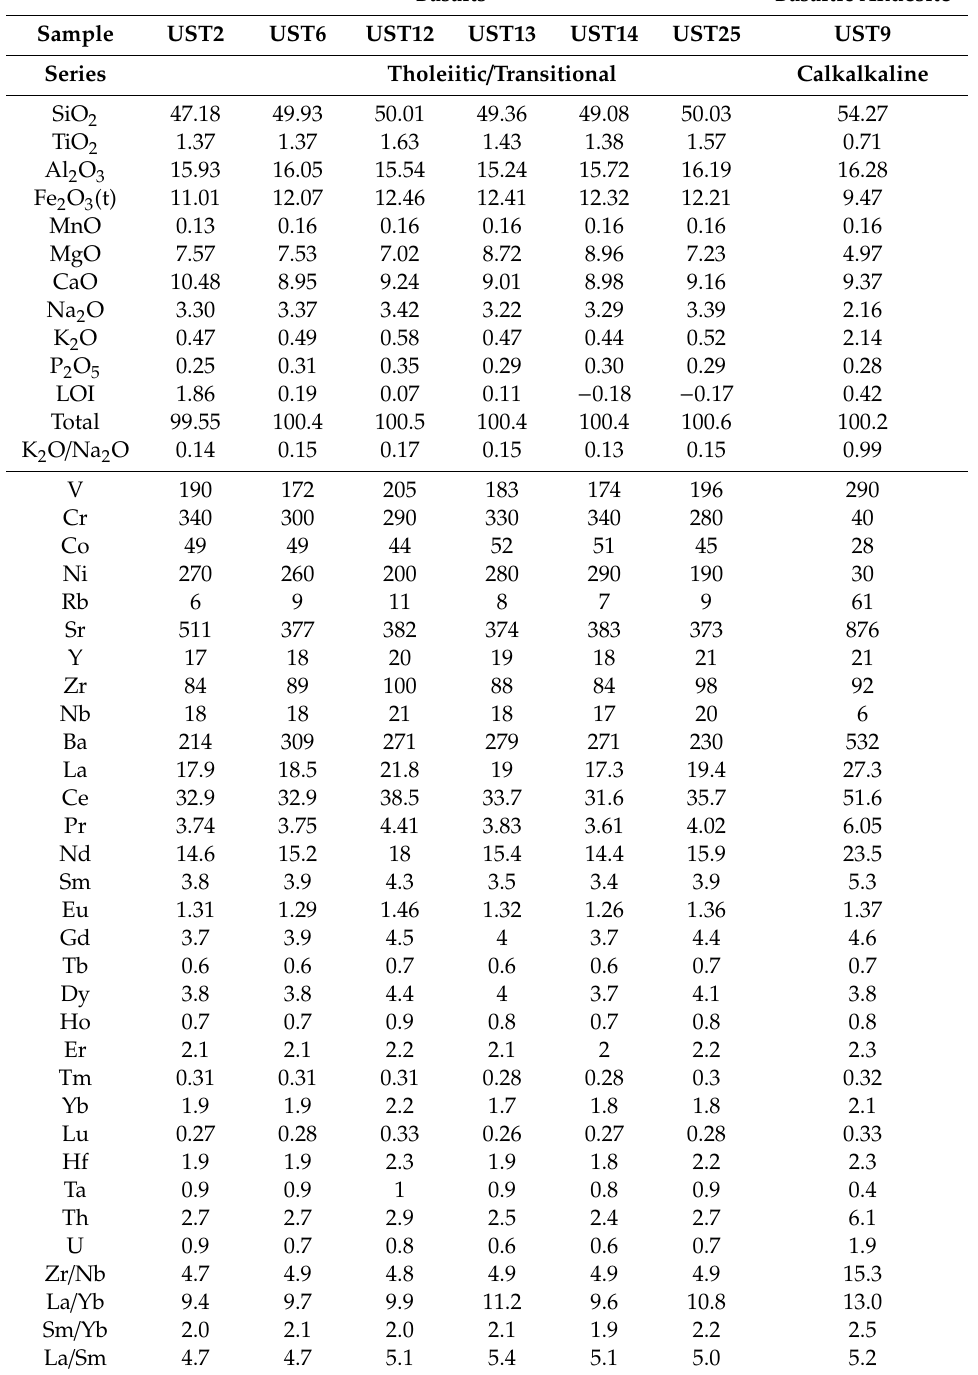
Table 4. Major (wt%) and trace elements (ppm) contents of the investigated millstones—basalts of the tholeiitic / transitional series and basaltic andesite of the Calcalkaline